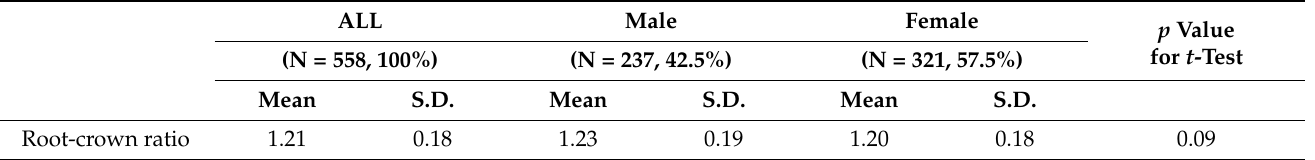
Table 1. Comparison of the mean root-crown ratios of maxillary central incisors according to sex.